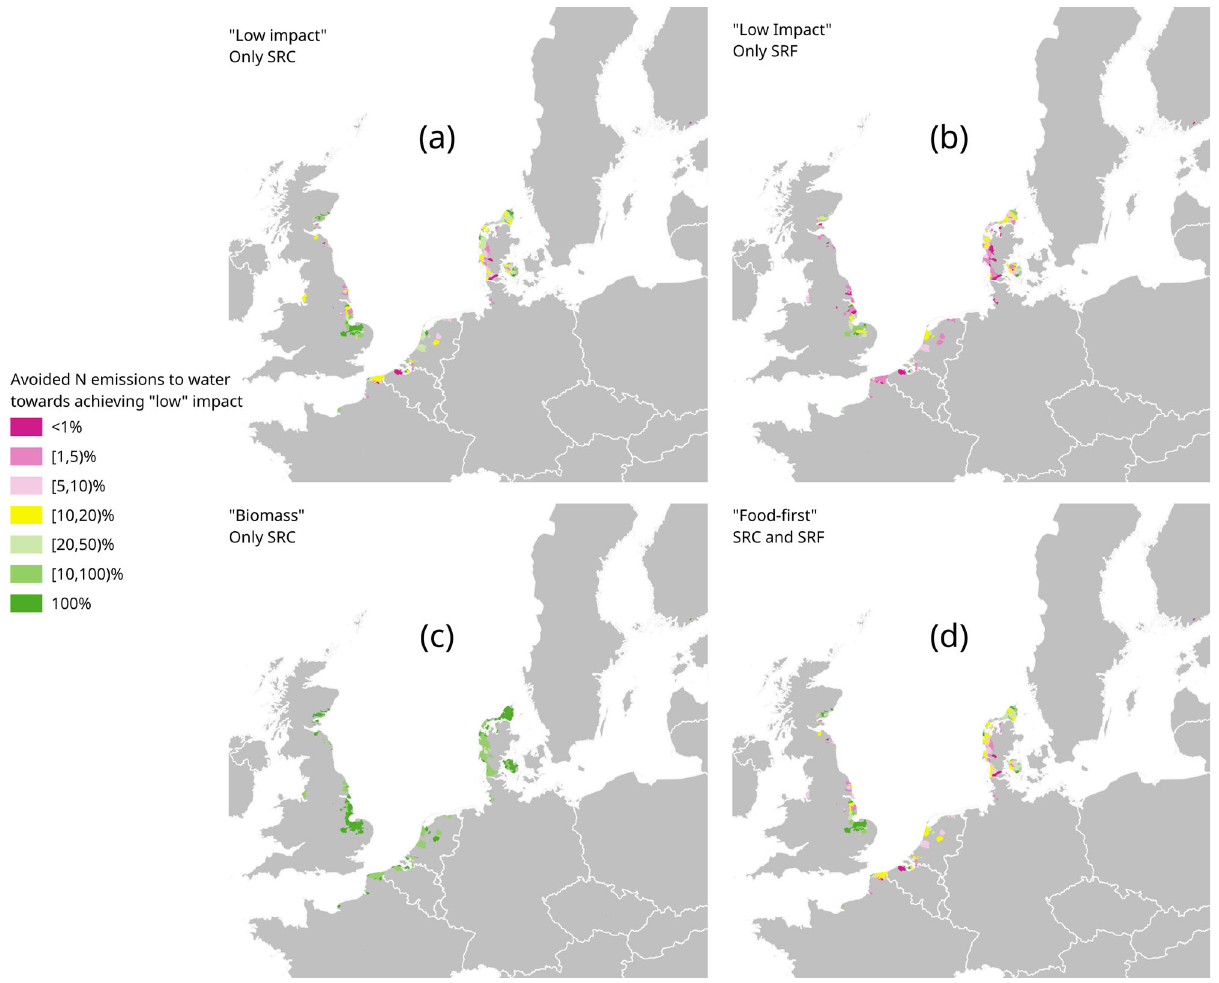
Fig. 7 Reduced N emissions to water due to implementation of windbreaks. Degree to which establishment of windbreaks contribute towards reducing N emissions to water down to a low-impact level, for the different deployment scenarios ( a – d ), and different windbreak options for the Low-Impact scenario ( a , b